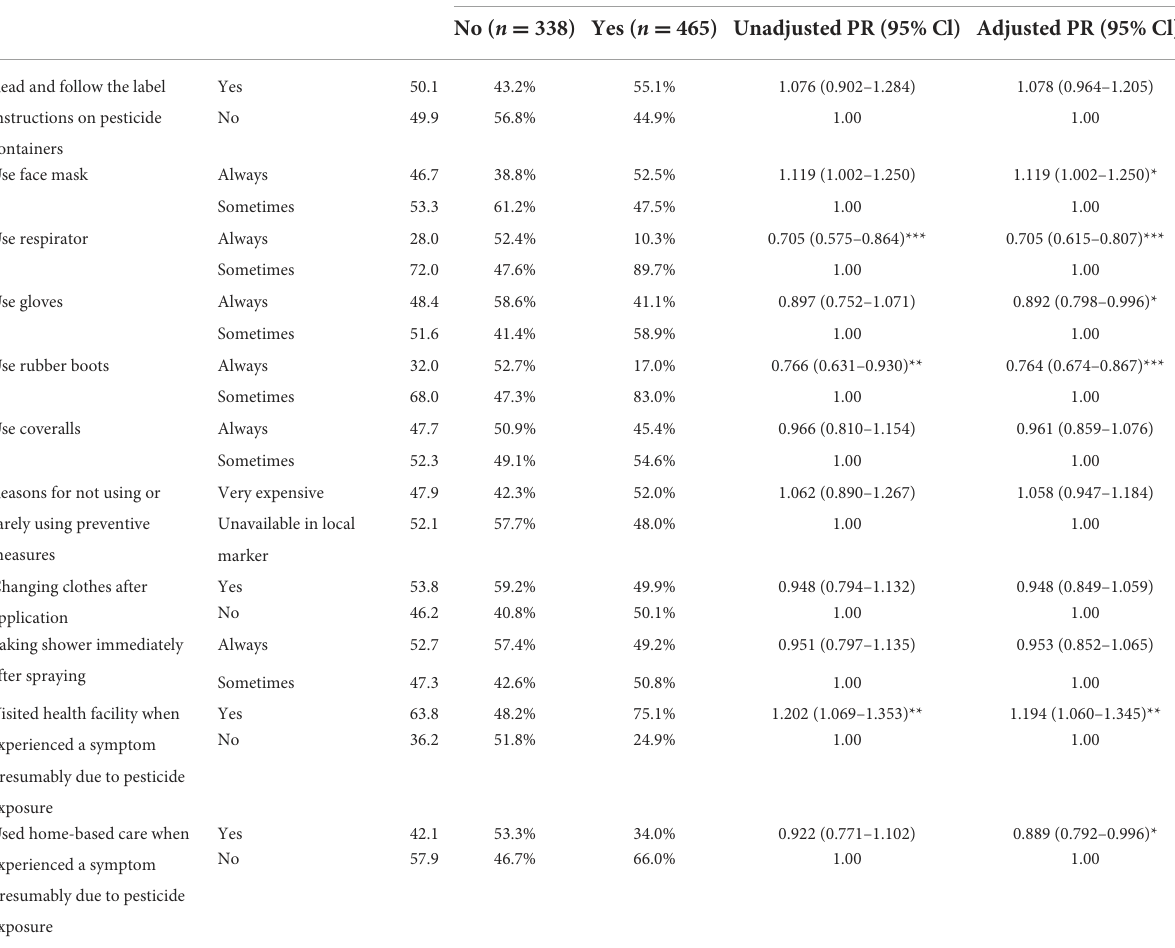
TABLE 10 Association between completing training on the health risks and use of pesticides, and applying preventive measures among pesticide applicators in East Hararge Zone, Oromiya Region, Ethiopia. Preventive